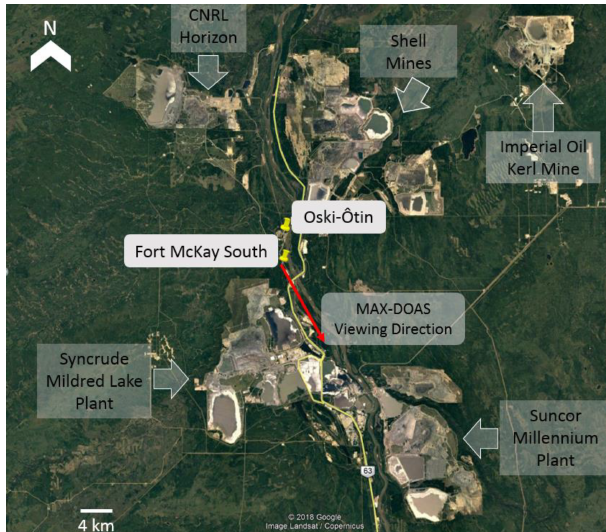
Figure 1. Location of field sites Fort McKay South and Oski-Ôtin and major industry